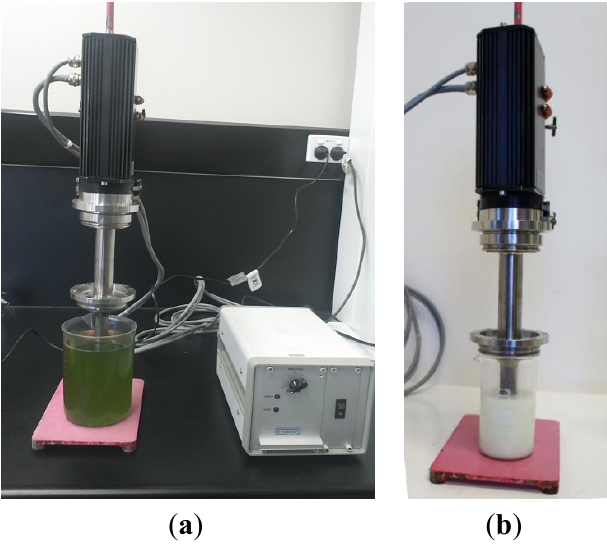
Figure 3. Ultrasound treatment, ( a ) braking down the colonies; ( b ) emulsion